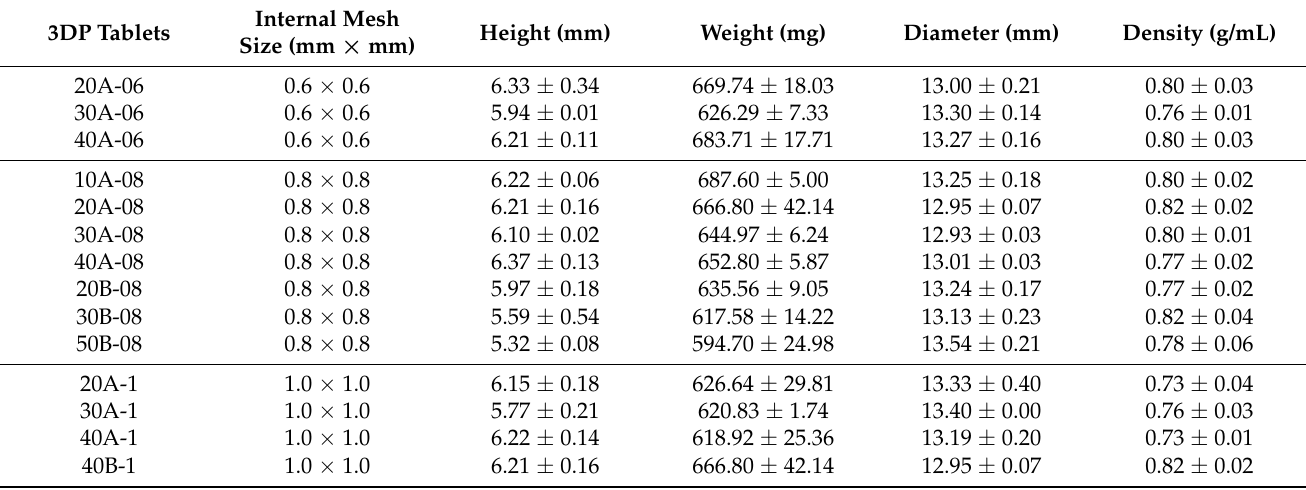
Table 2. Physical characterization of the 3DP tablets. The numbers after the hyphen indicate the